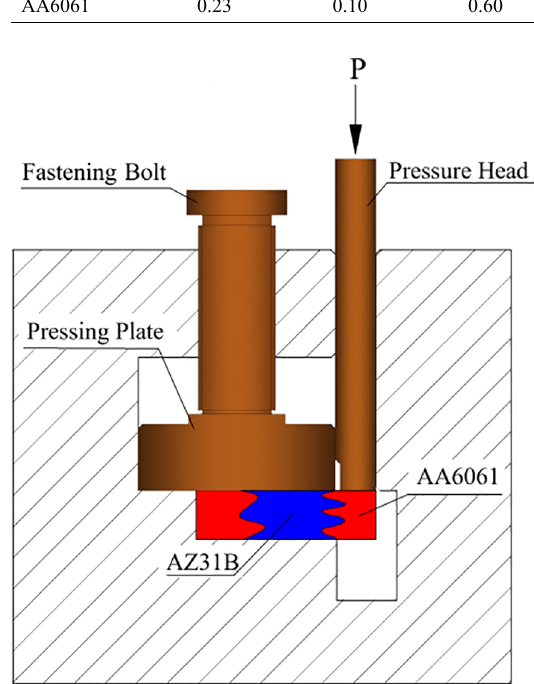
Figure 2. The schematic diagram of the shear test.